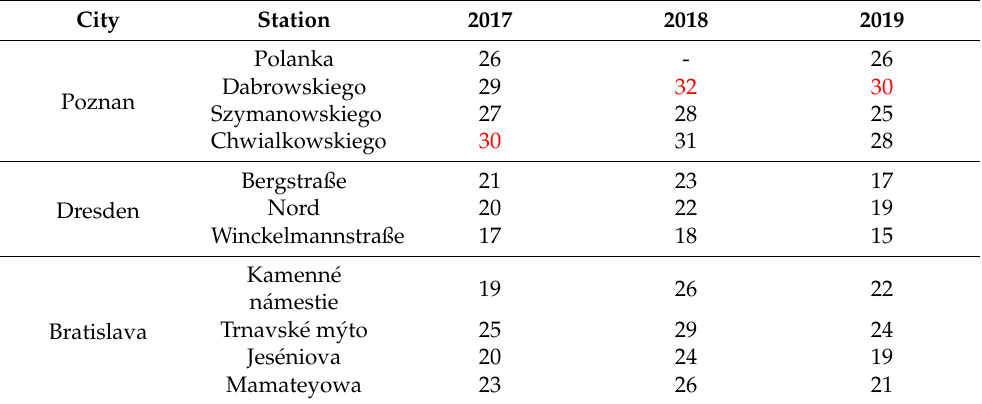
Table 2. Average annual concentration of PM10 in European cities with the highest annual value in ug/m 3